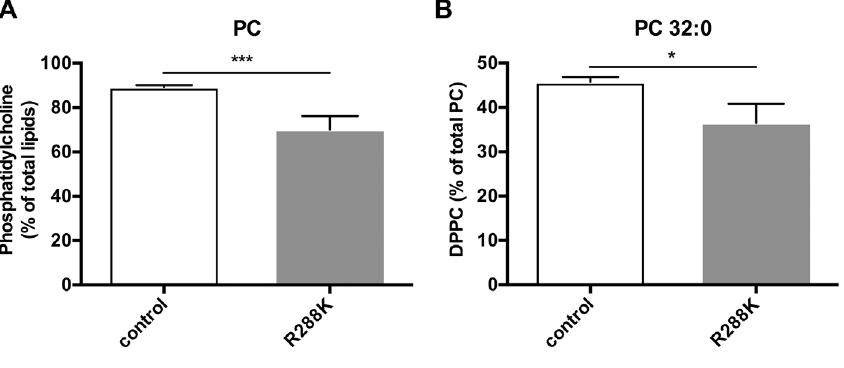
Figure 1. Levels of phosphatidylcholine and dipalmitoyl-phosphatidylcholine in bronchoalveolar lavage fluid of infants heterozygous for R288K in ABCA3. (A) Phosphati- dylcholine of patients carrying heterozygote R288K variant (n = 4) compared with healthy control group (n = 11). Data are shown in % of all analyzed PL classes measured in BAL. (B) Dipalmitoyl-phosphatidylcholine amounts of healthy patients (n = 11) and patients with R288K variant (n = 4) measured in BAL. Data are shown in % of total PC. All results were expressed as mean ± SEM. * P < 0.05; *** P <